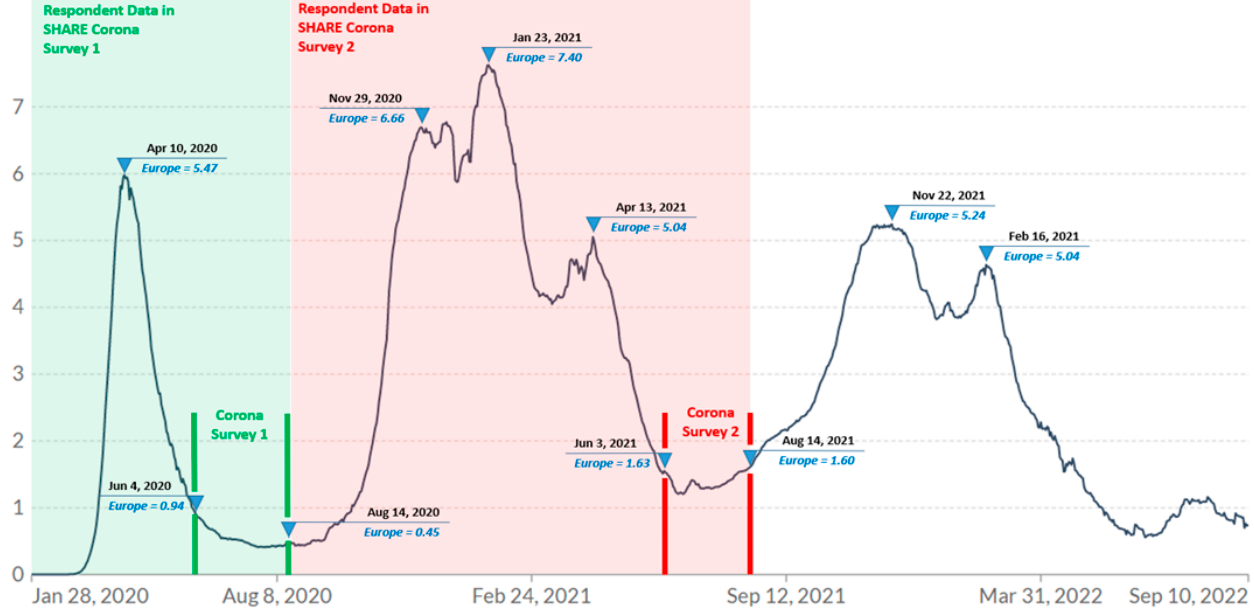
Figure 2. Daily new confirmed COVID-19 deaths per million people (7-day rolling average). Data from the COVID-19 Data Repository by the Center for Systems Science and Engineering (CSSE) at Johns Hopkins University via Our World in Data [33] with own modification indicating the survey period. https://github.com/CSSEGISandData/COVID-19 (accessed on 30 July 2022). Note: Inverted triangles on the red lines indicate the start and end of the SHARE Corona survey 2. The inverted triangles on the curve indicate the peaks of the pandemic waves with the average daily number of confirmed COVID-19 deaths per million people. The red-shaded zone indicates the time period corresponding to retrospective questions in Survey 2 while the green-shaded zone indicates that of Survey 1.